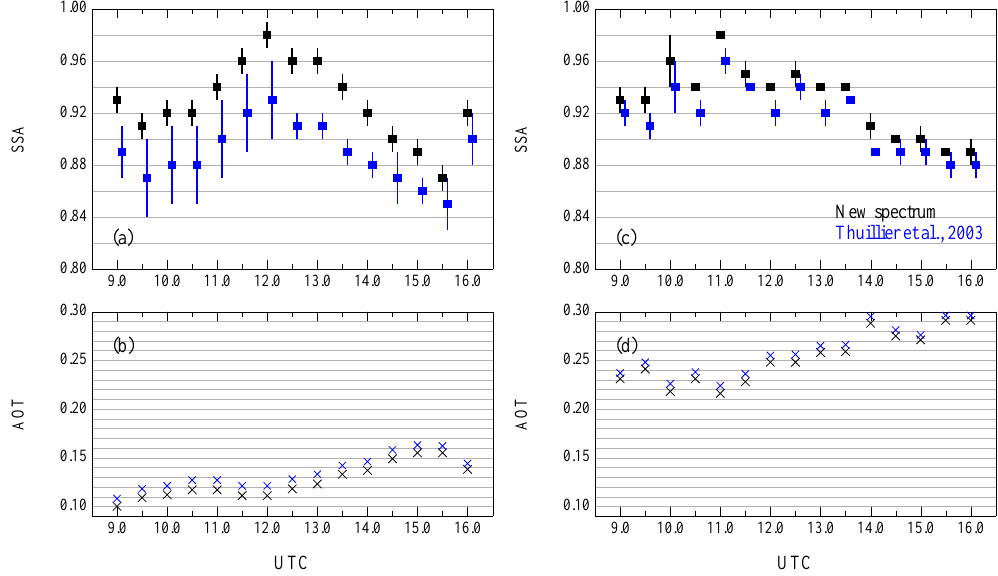
Fig. 3. Daily variations of AOT and SSA at 440nm retrieved from spectroradiometer’s measurements on a day characterized: (a)–(b) by a low aerosol content (12 June 2006); (c)–(d) by a high aerosol content (11 September 2006). Black symbols are retrievals with the “new spectrum”, blue ones are retrievals with Thuillier et al. (2003) spectrum. Vertical bars in (a) and (c) are the standard deviations around the mean SSA computed over 5nm interval.